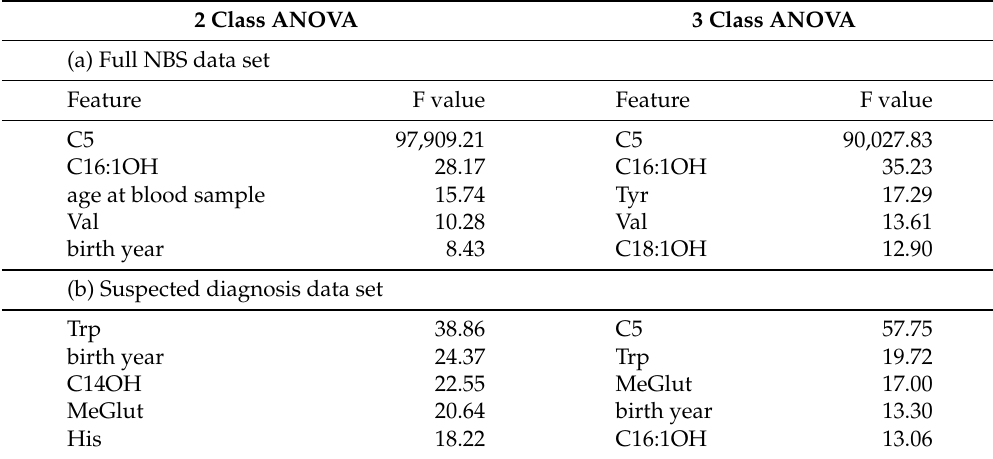
Table 2. ANOVA results with all presented features having a p -value p < 0.05. All methods were applied to the full NBS data set (a) and the suspected diagnosis data set (b). For 2 class ANOVA, five features with the largest F values with binary target variable normal or IVA, and for 3 class ANOVA, five features with the largest F values with target variable normal (false positive for (b)), mild IVA, and classic IVA are presented. Abbreviations: ANOVA—analysis of